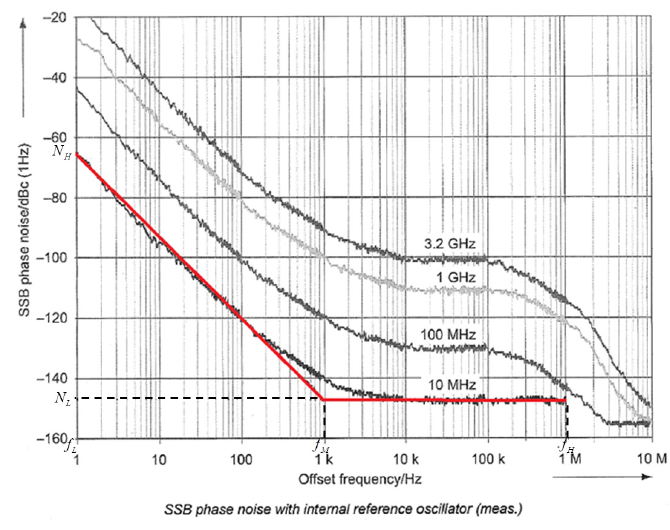
Figure A2. RF generator’s N SSB − f chart and linear approximation of its curve (red line). The figure corresponds to Rohde & Schwarz SMC100A generator (with permission from Rohde &